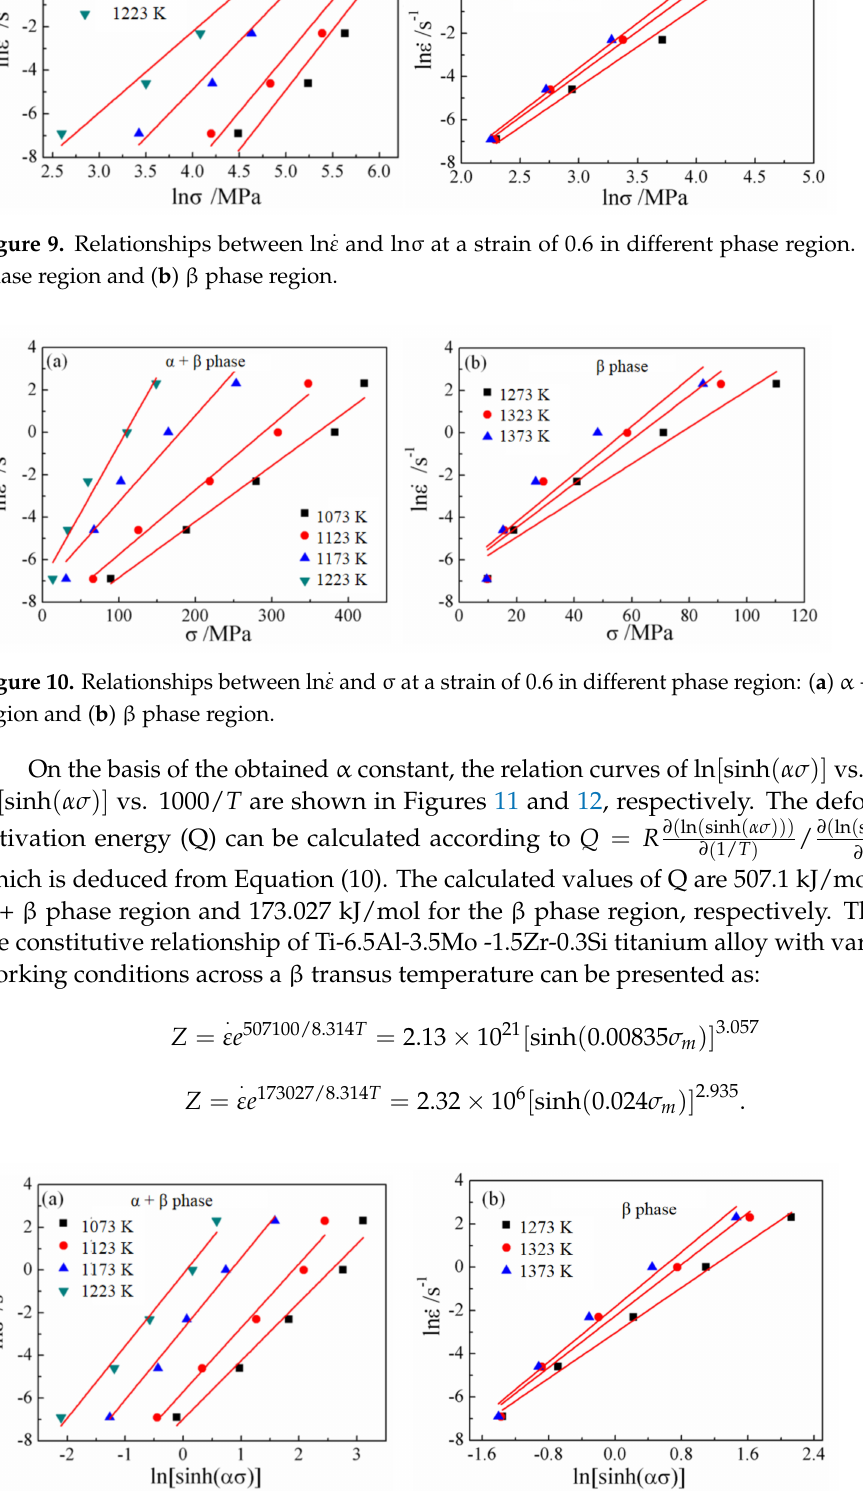
Figure 11. Relationships between ln[sinh( ασ )] and ln phase